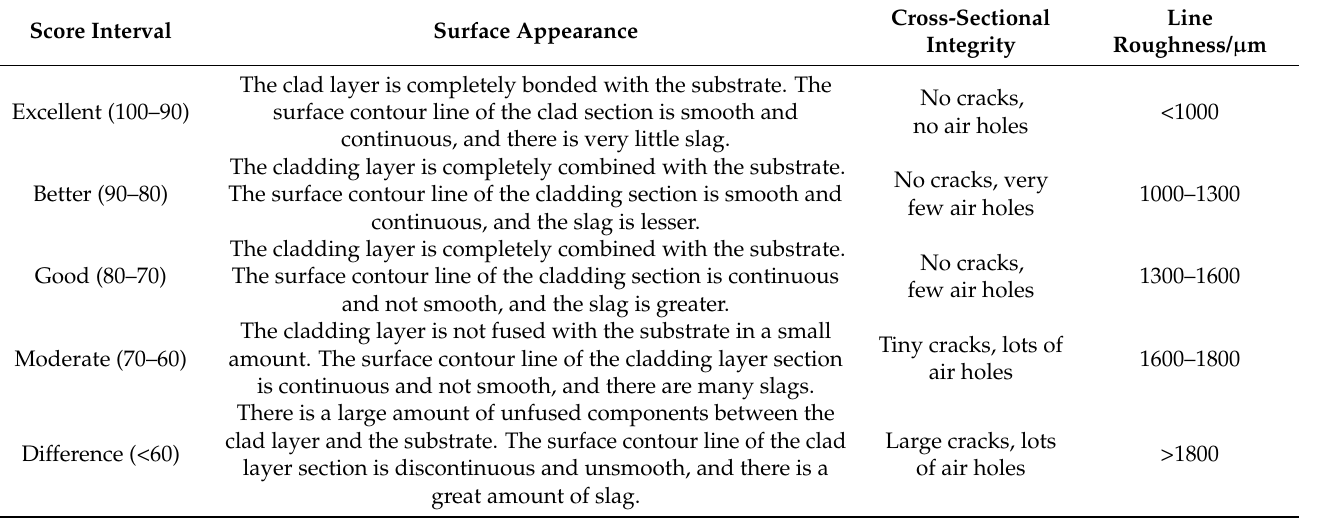
Table 1. Basis for determining the macroscopic quality of the coating.